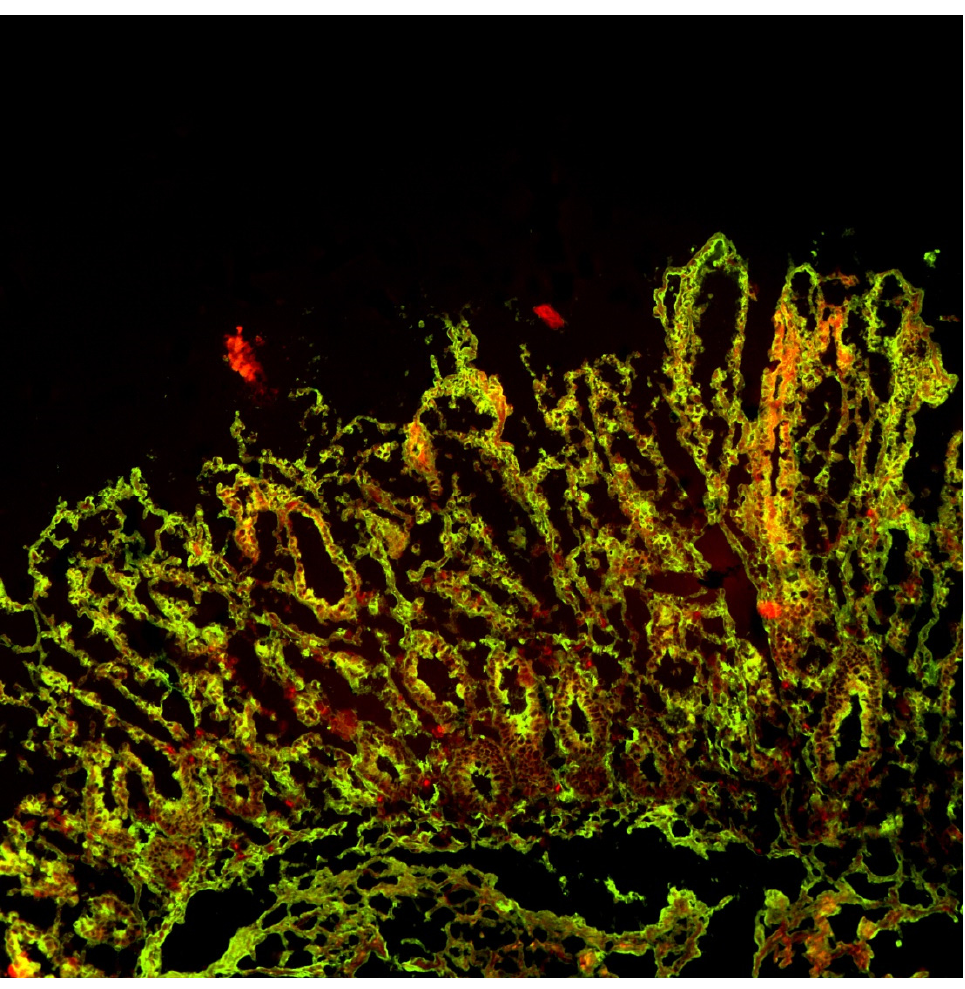
Figure 4. In yellow, the overlap of green and red indicates the deposits of anti ‐ tTG2 on confocal microscopy.